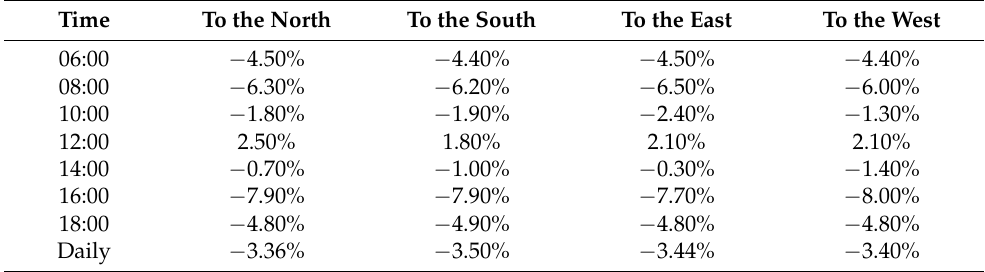
Table 3. The differences between sunlit leaf fractions calculated based on displaced point clouds and the reference one calculated based on the non-displaced point cloud (differences = displaced— non-displaced).